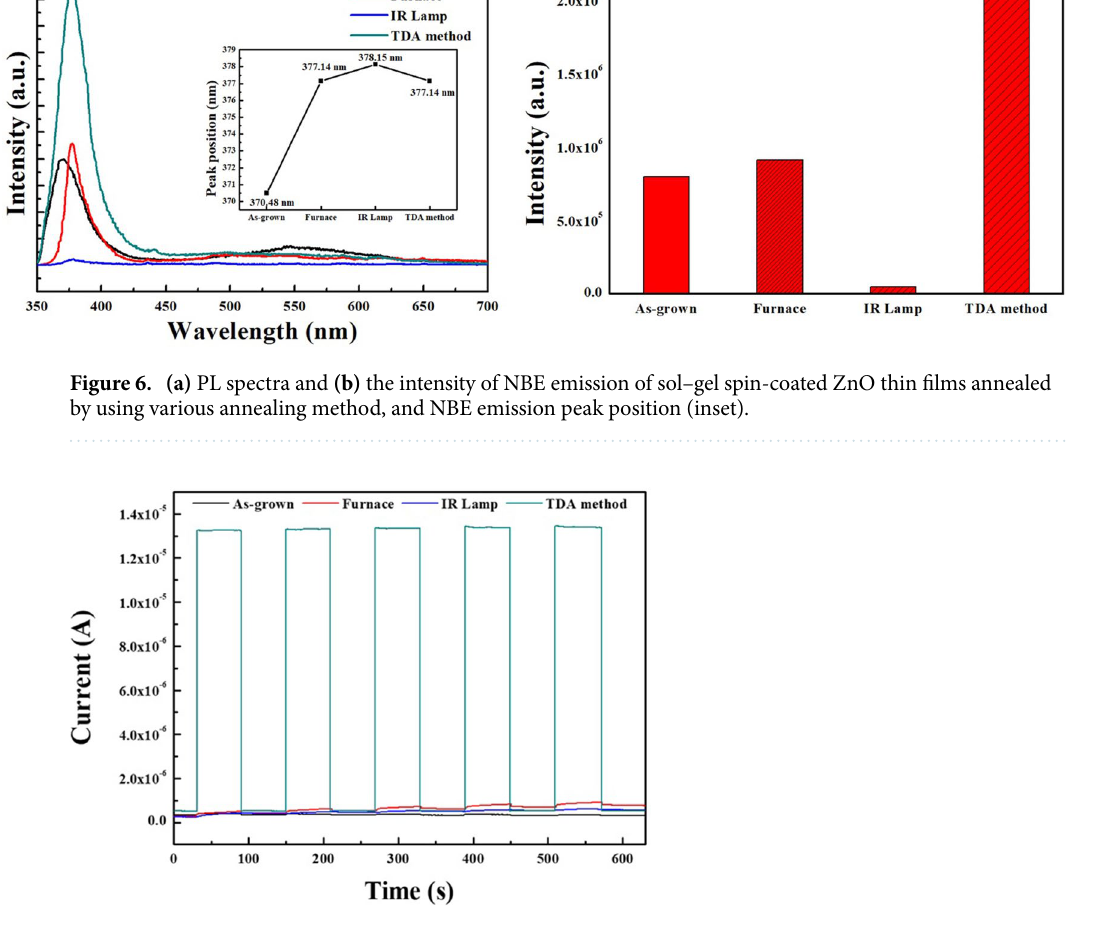
Figure 7. Time-dependent UV photoresponse of non-annealed ZnO thin films and annealed ZnO thin films by using furnace, IR lamp, and TDA